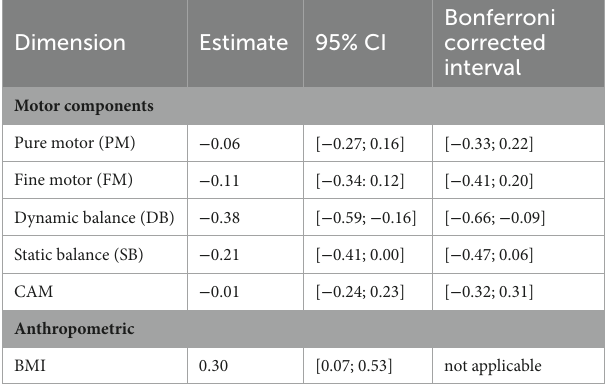
TABLE 2 Estimated secular trend based on ZLS-3 data: average change in SDS between two cohorts born 10 years apart for five motor components of the ZNA and BMI, with 95% CI with and without Bonferroni correction for multiple testing.